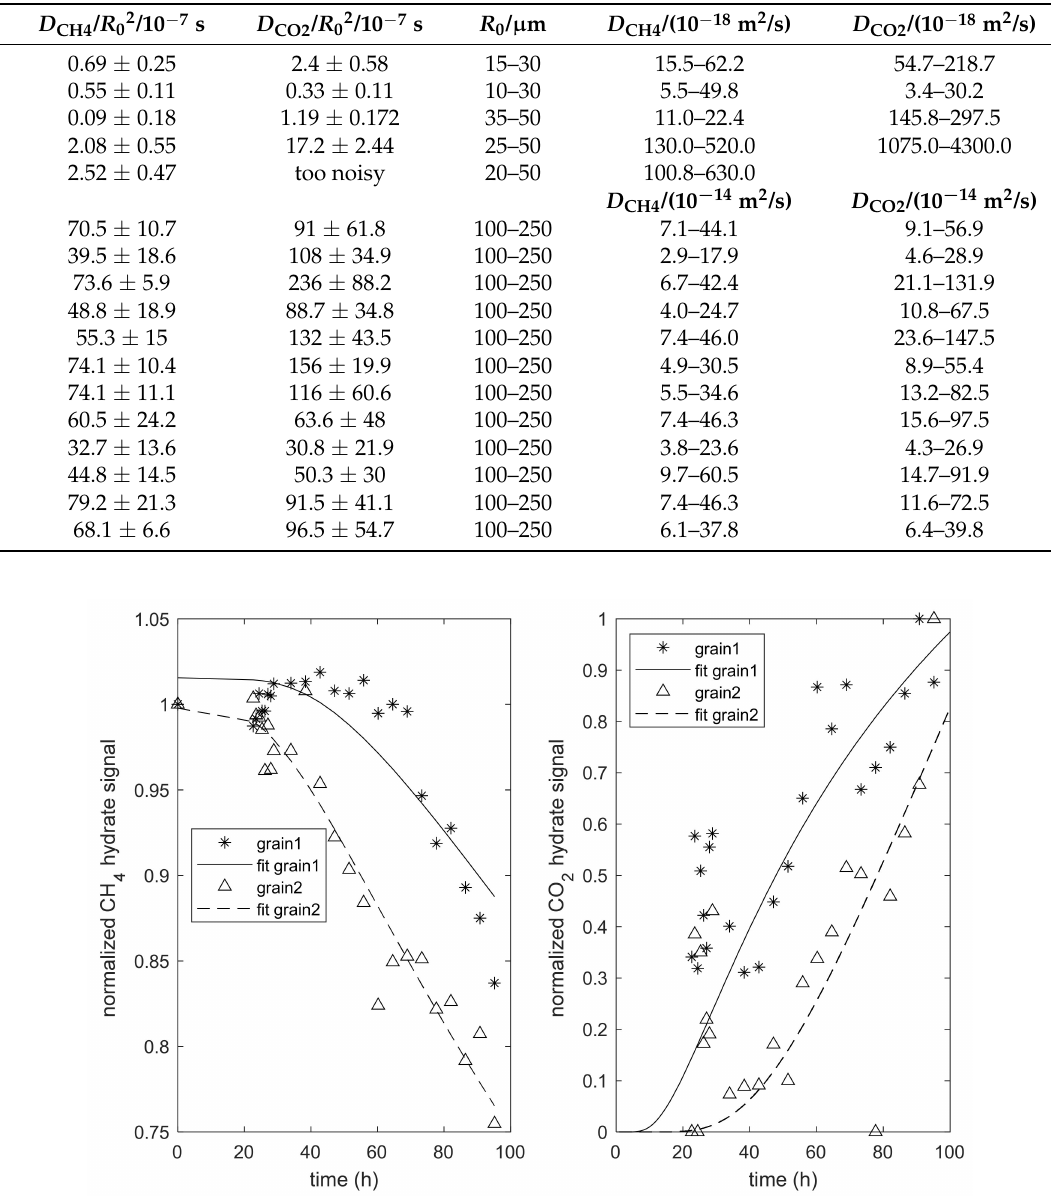
Table 3. Regression parameters D / R 02 for diffusion on single gas-hydrate grains. For NoFlowI2 , no gas hydrate grains with gas exchange could be identified. Estimates for grain size ranges are listed with corresponding ranges for diffusion coefficients.